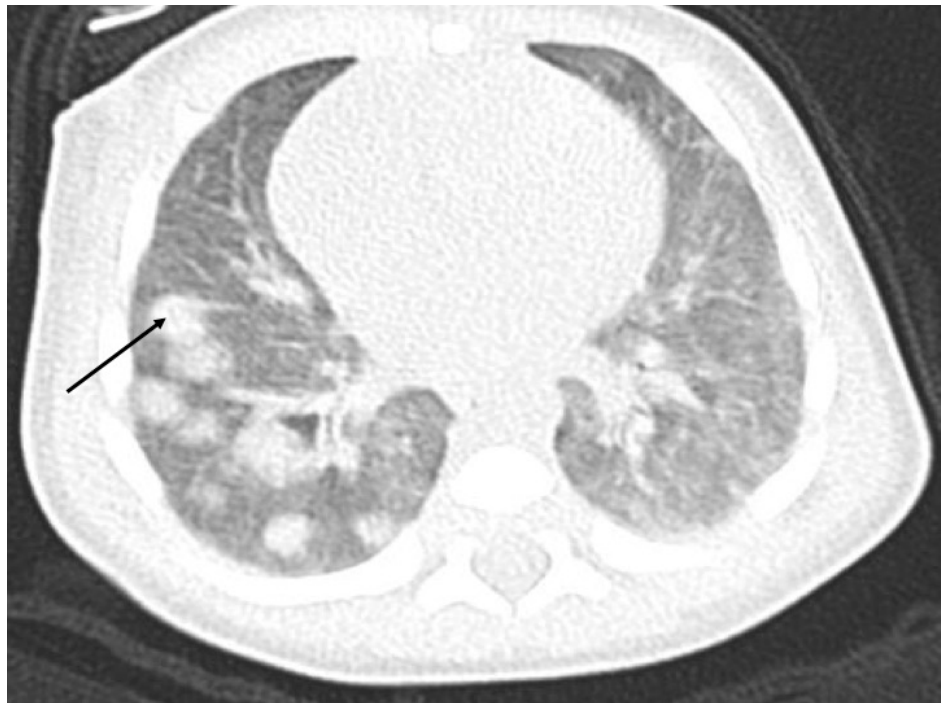
Figure 1. Chest CT with numerous metastatic lesions in both lungs. An abdominal nonenhanced (A) and enhanced arterial phase (B) coronal view, arte- rial phase (C) and portal phase (D) axial view indicate on the hepatic mass with bleeding (A), and central necrosis (Figure 2). After gadolinium contrast injection, there is poor pe- ripheral enhancement in the arterioportal phase (C) and in the late portal venous phase, the CT image shows poor hypodense lesions (D) (Figure 2).